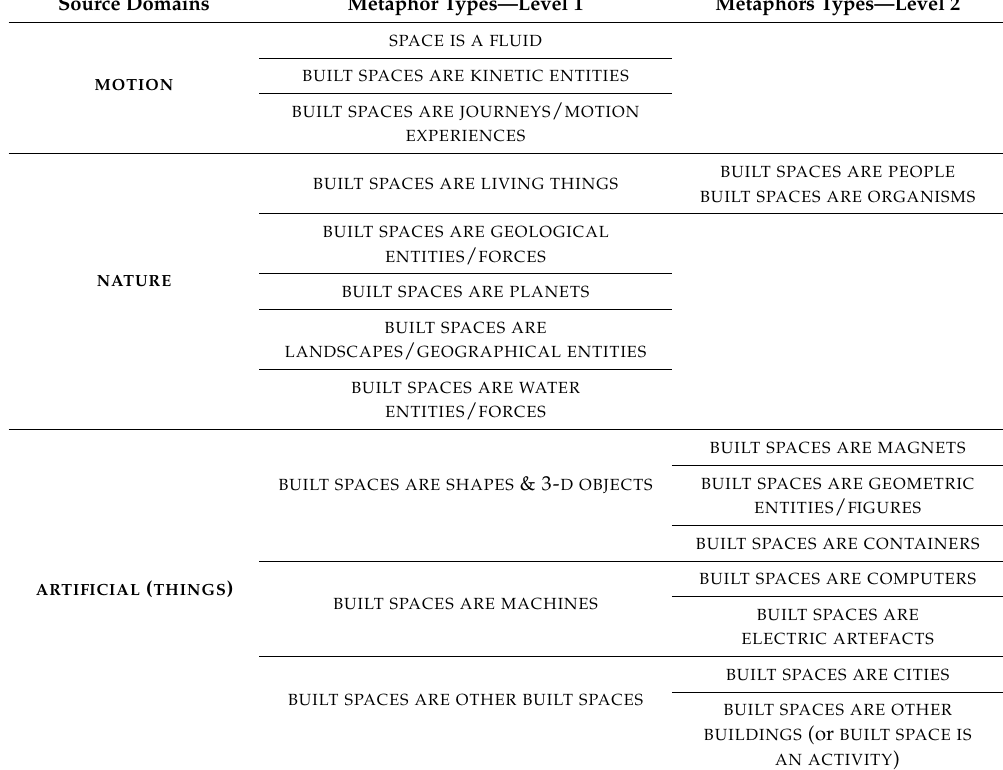
Table 1. Categorization of metaphor types into levels and experiential